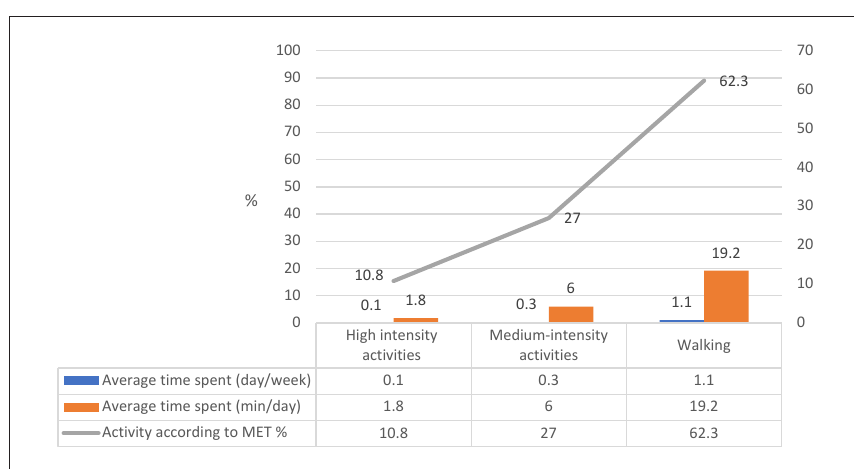
Figure 1. Distribution of respon- dents according to the average physical activity intensity indica- tors in the low FA level group